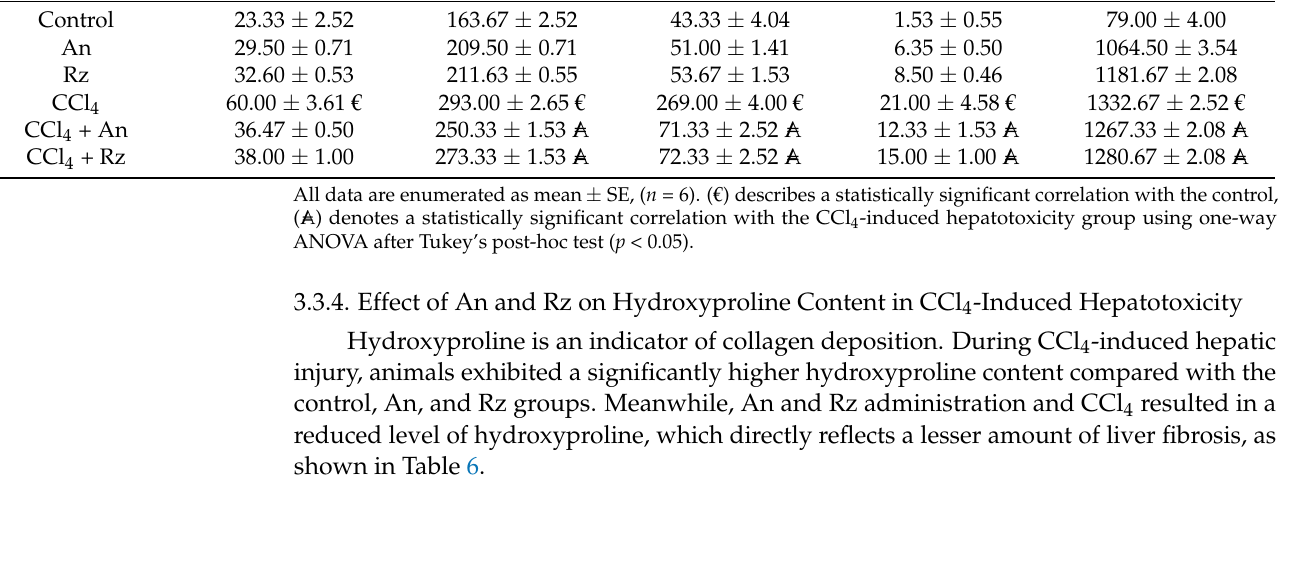
Table 5. Ameliorative effects of An, Rz administration on the serum levels of liver enzymes including ALT, AST, ALP, γ GT, and LDH in CCl 4 -induced hepatotoxicity. Animal